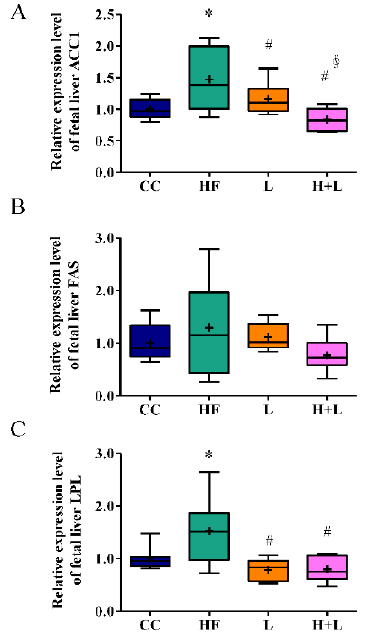
Figure 4. Histological manifestations of the fetal liver with a maternal high-fat diet (HF) and pre- natal Lactobacillus reuteri (H + L) or prenatal sodium butyrate treatment (H + B). ( A ) The degree of fetal hepatic steatosis is presented as vacuolation in the H&E stain. ( B ) The fetal liver oxidative stress was higher with a maternal high-fat diet (HF) compared to a controlled maternal diet (CC); 8-hydroxy-2-deoxyguanosine (8-OHdG) was used to determine oxidative stress. * Compared to the CC group, p < 0.05; # compared to the HF group, p < 0.05; ∮ compared to the H + L group, p < 0.05. IOD, image optical density. The diagram shows the mean level (cross symbol) “+”.